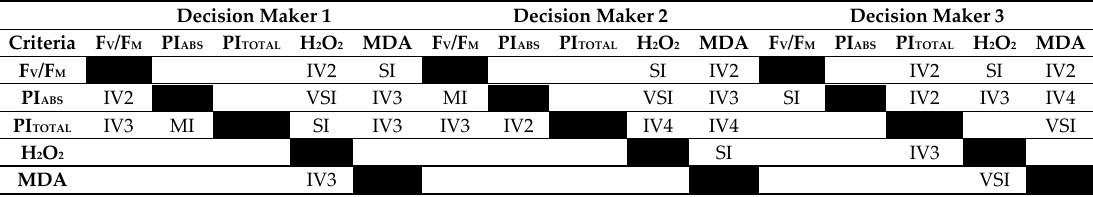
Table 6. Pairwise comparisons of decision makers concerning criteria of drought stress.